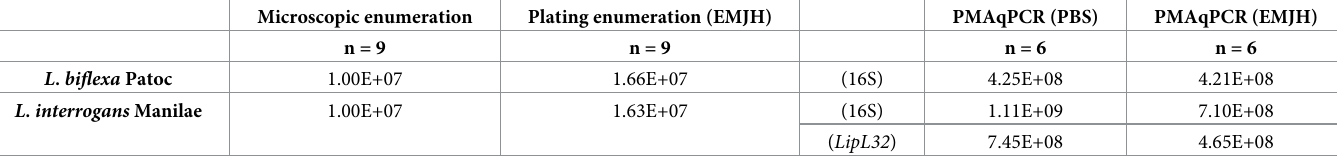
Table 3. Comparison of Leptospira detection between microscopy, plating and molecular analysis.